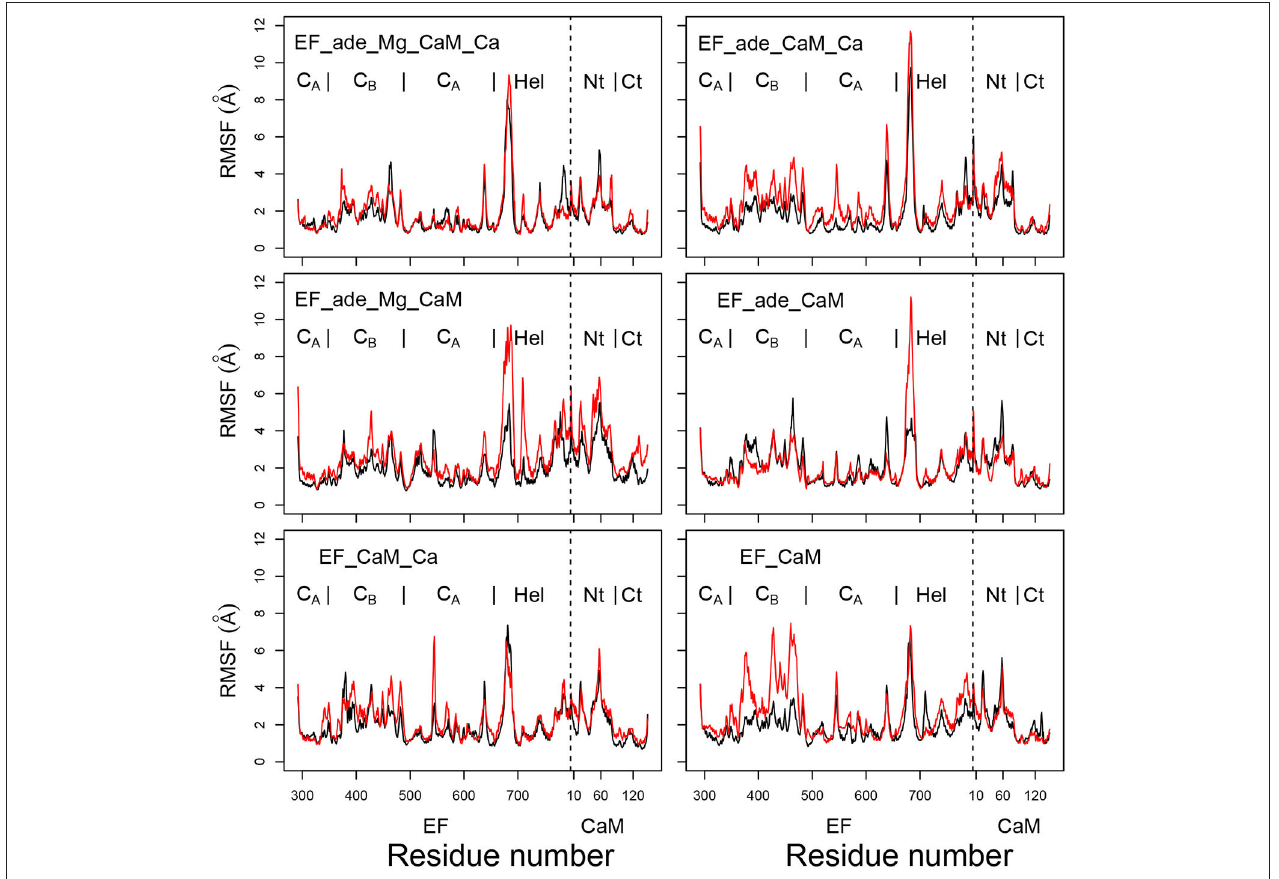
FIGURE 3 | Coordinate root-mean-square fluctuations (RMSF: Å) of the backbone heavy atoms of the complex EF/CaM, each frame being superimposed on the chains A and D of the PDB entry 1PK0. For each trajectory, the black and red curves correspond to replicas R1 and R2. The N terminal residue of CaM is indicated by a vertical dashed line, the EF and CaM regions are labeled on the top of each plot. The N-CaM and C-CaM regions are labeled Nt and Ct for sake of